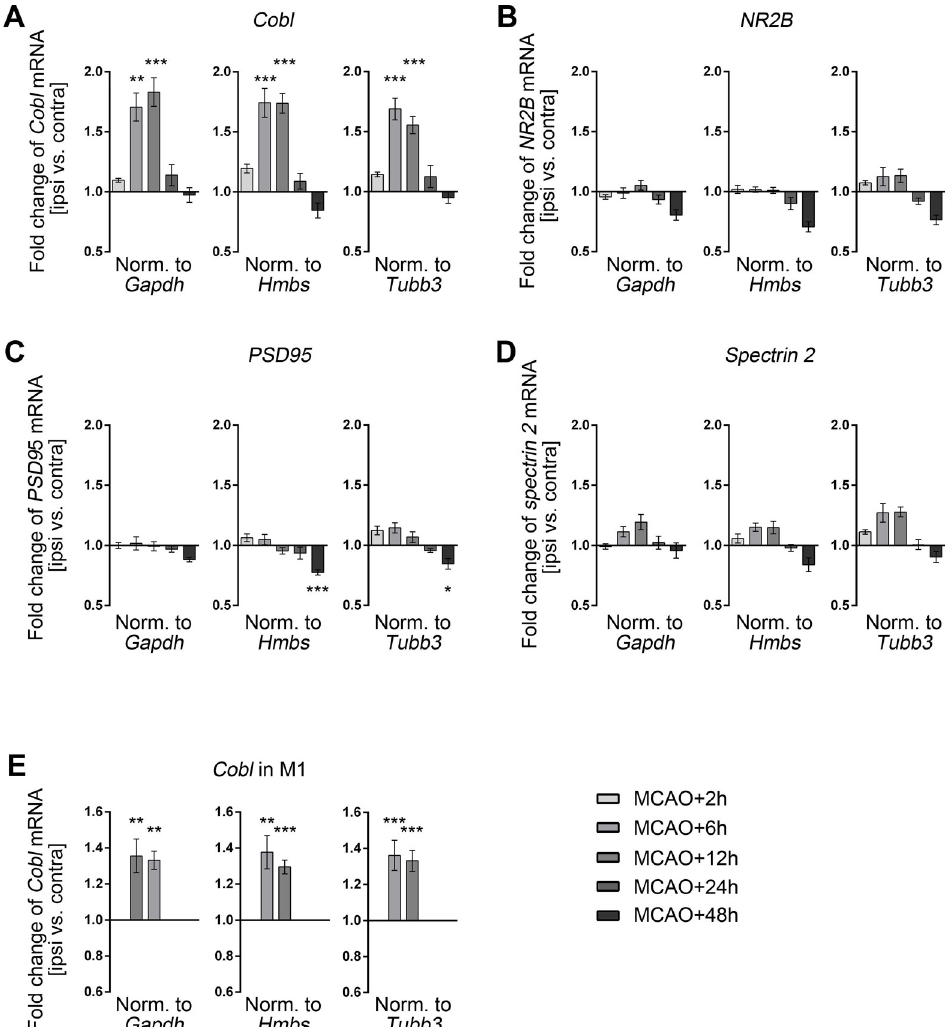
Fig 3. qPCR analyses demonstrate a transient increase of Cobl mRNA levels following the decline of Cobl protein levels upon MCAO. A–D , Fold change of mRNA levels of Cobl ( A ), NR2B ( B ), the scaffolding proteins PSD95 ( C ), and spectrin 2 ( D ) determined in the middle segment of the brain (+0.8 and − 1.2 mm to bregma) by qPCR after 2 hours, 6 hours, 12 hours, 24 hours, and 48 hours of reperfusion after 30-minute MCAO. Data represent the differences of Cobl , NR2B , PSD95 , and spectrin 2 mRNA levels (ipsi versus contra) normalized to Gapdh (left panel), to Hmbs (middle panel), and to the neuronally expressed gene Tubb3 (right panel), respectively. Brain samples from 6 to 9 mice were analyzed for each time point. E , Fold changes of Cobl mRNA levels in M1 tissue samples (ipsi versus contra) at the times of up-regulation identified above (6 hours and 12 hours after MCAO). The data were again normalized against 3 different genes ( Gapdh , Hmbs , and Tubb3 ). A , n MCAO+2h = 8; n MCAO+6h = 8; n MCAO+12h = 9; n MCAO+24h = 6; n MCAO+48h = 6 mice. B–D , n MCAO+2h = 7; n MCAO+6h = 8; n MCAO+12h = 7; n MCAO+24h = 6; n MCAO+48h = 6 mice. E , n MCAO+6h = 7; n MCAO+12h = 8. Data represent mean ± SEM. Statistical significances (ipsi versus contra) were calculated using 1-way ANOVA with Sidak posttest. � P < 0.05; �� P < 0.01; ��� P < 0.001. The numerical data underlying this figure can be found in S3 Data . MCAO, middle cerebral artery occlusion; qPCR, quantitative